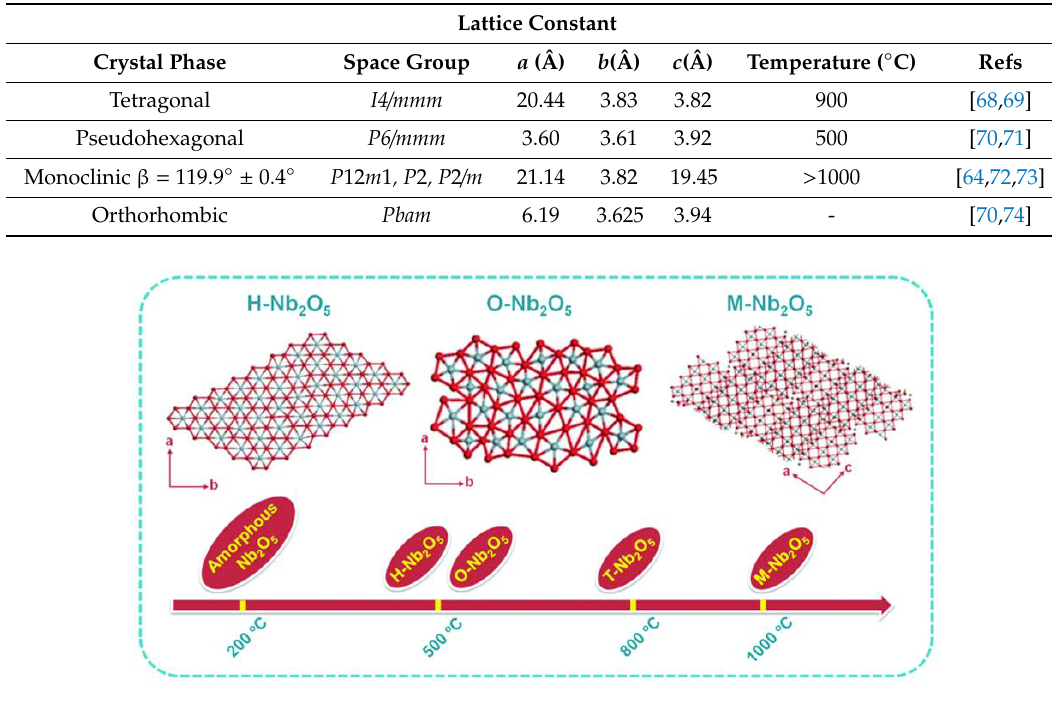
Figure 1. Structural stages of H-Nb 2 O 5 , O-Nb 2 O 5 and M-Nb 2 O 5 , together with the Nb 2 O 5 crystal phase evolving with respect to temperature